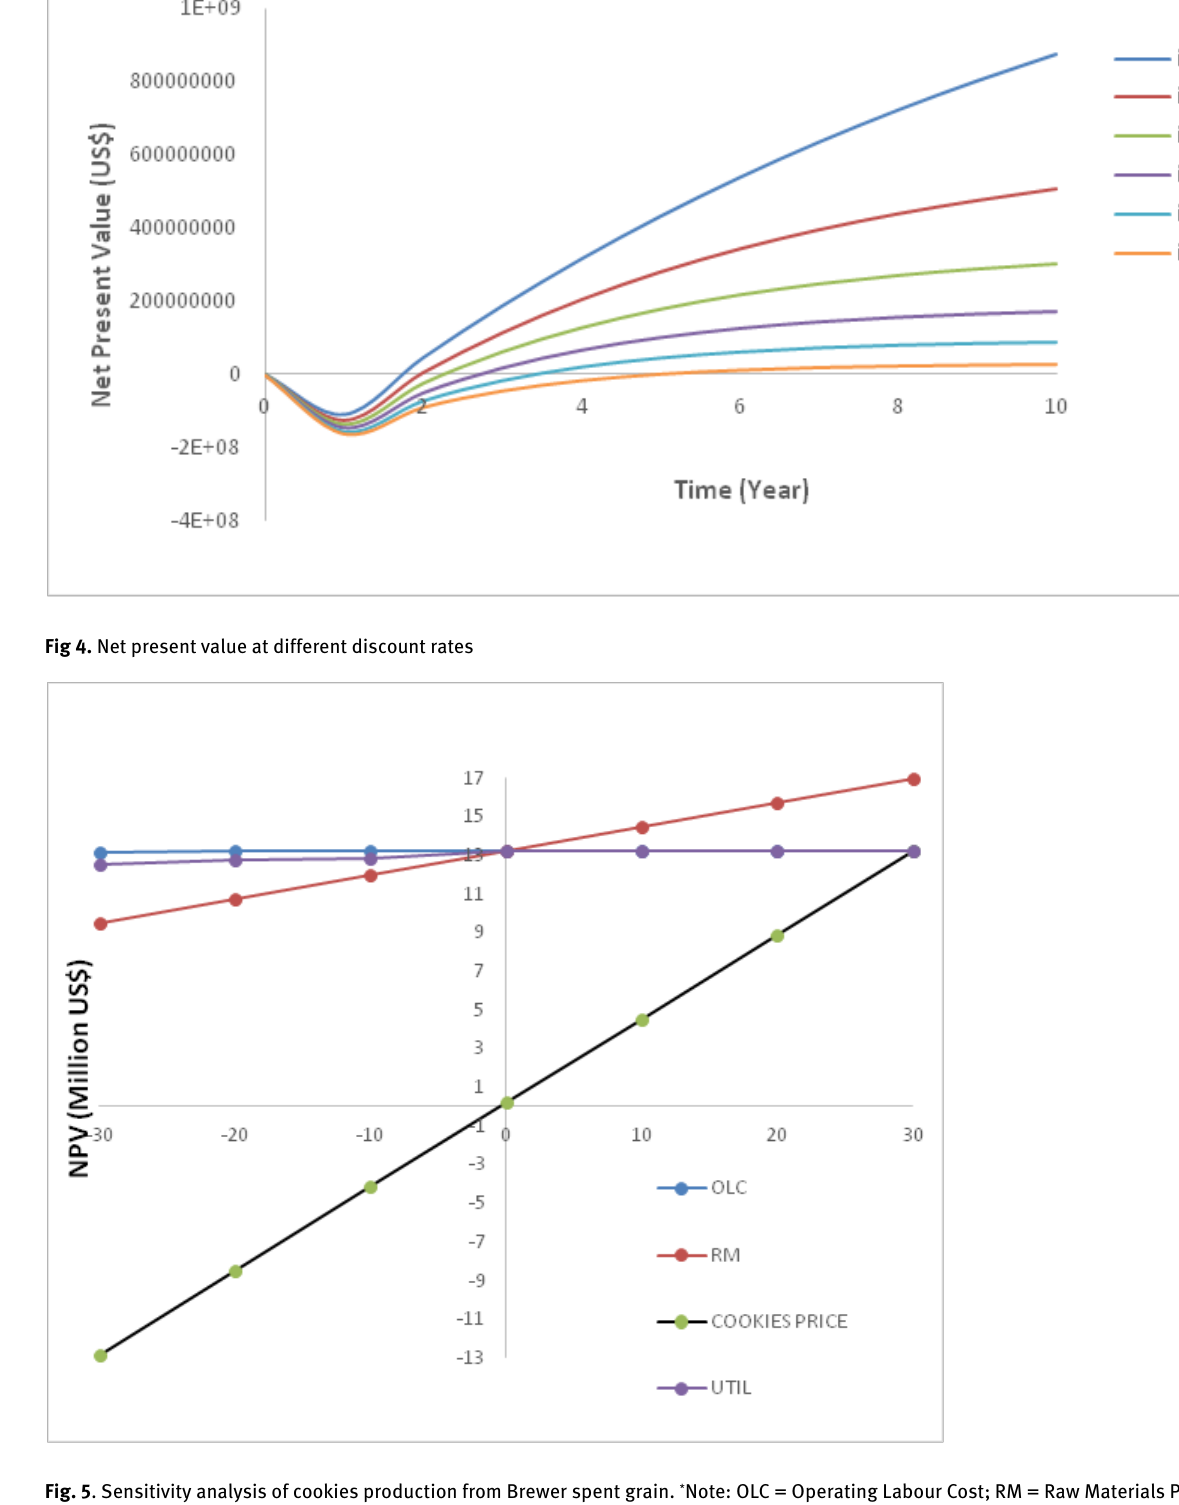
Fig. 5 . Sensitivity analysis of cookies production from Brewer spent grain. * Note: OLC = Operating Labour Cost; RM = Raw Materials Price; Util = Utility cost